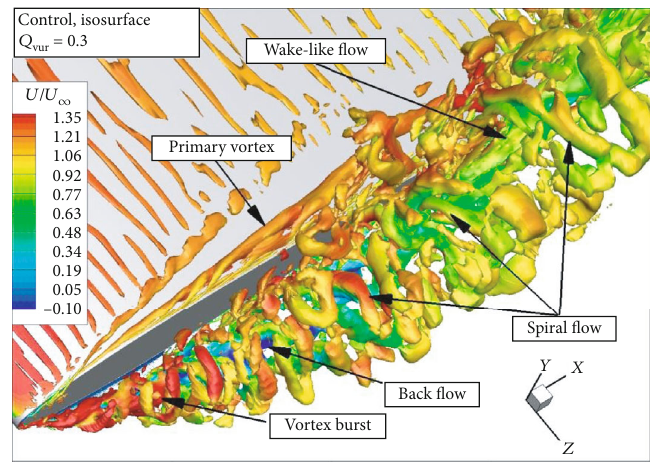
Figure 22: The structure of the induced vortex under normal blowing.